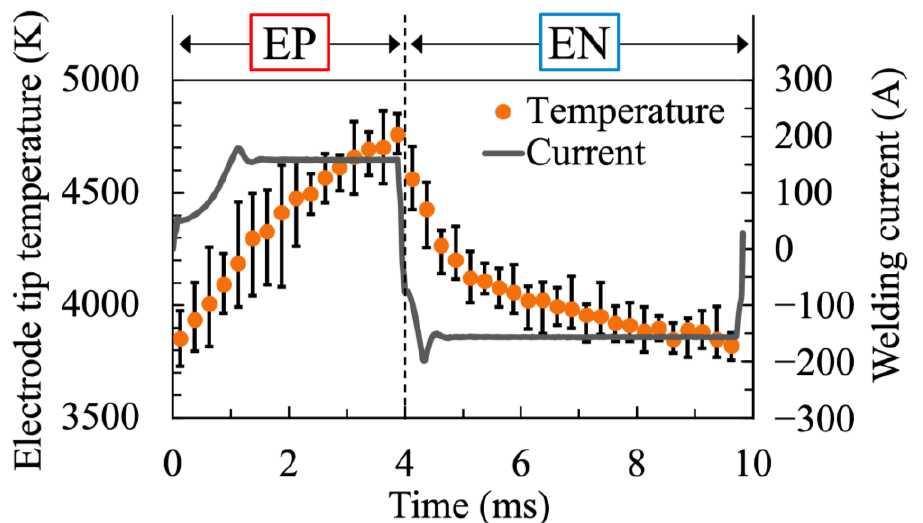
Figure 12. Temperature variation of the electrode tip during AC cycles.